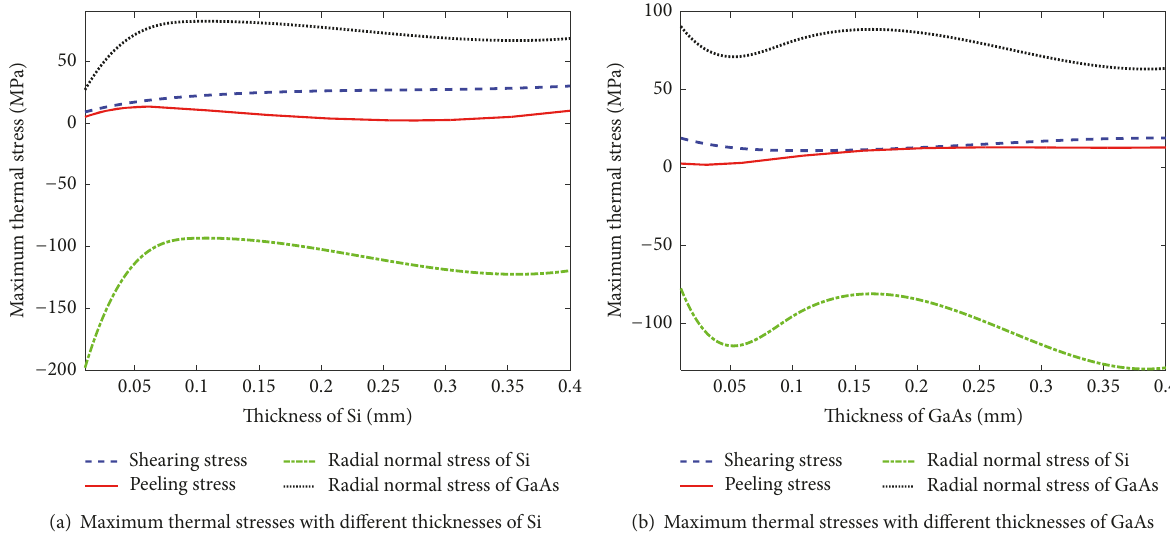
Figure 9: The diagrams of maximum thermal stresses in bonding interfaces with different